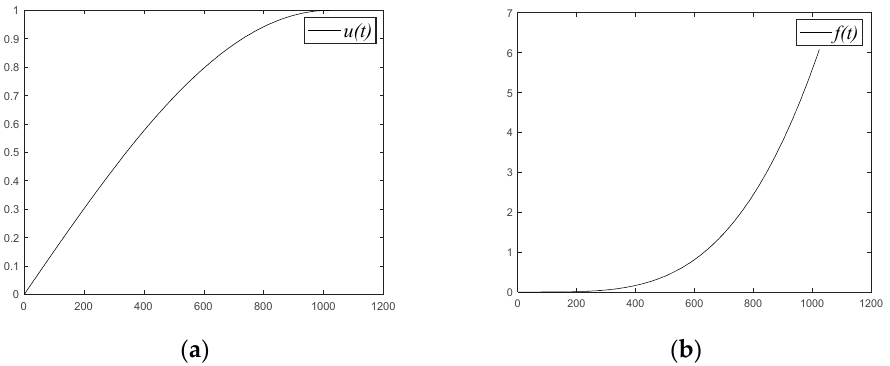
Figure 3. The boundary value problem for heat equation: ( a ) the exact solution 𝑢(𝑡). ; ( b ) 𝑢(𝑥, 𝑡) = 𝑓(𝑡) where 𝑡 ∈ [0,𝑇] , 𝑥 = 0.5 and 𝑇 = 5 .